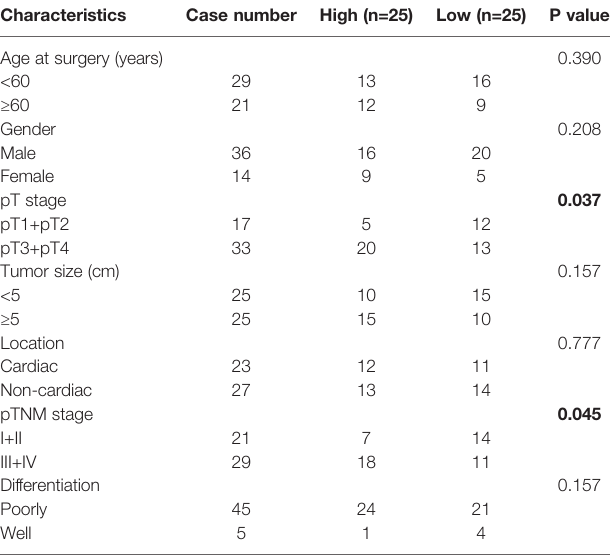
TABLE 1 | Correlation between circDNMT1 expression and clinicopathological characteristics of 50 GC patients.